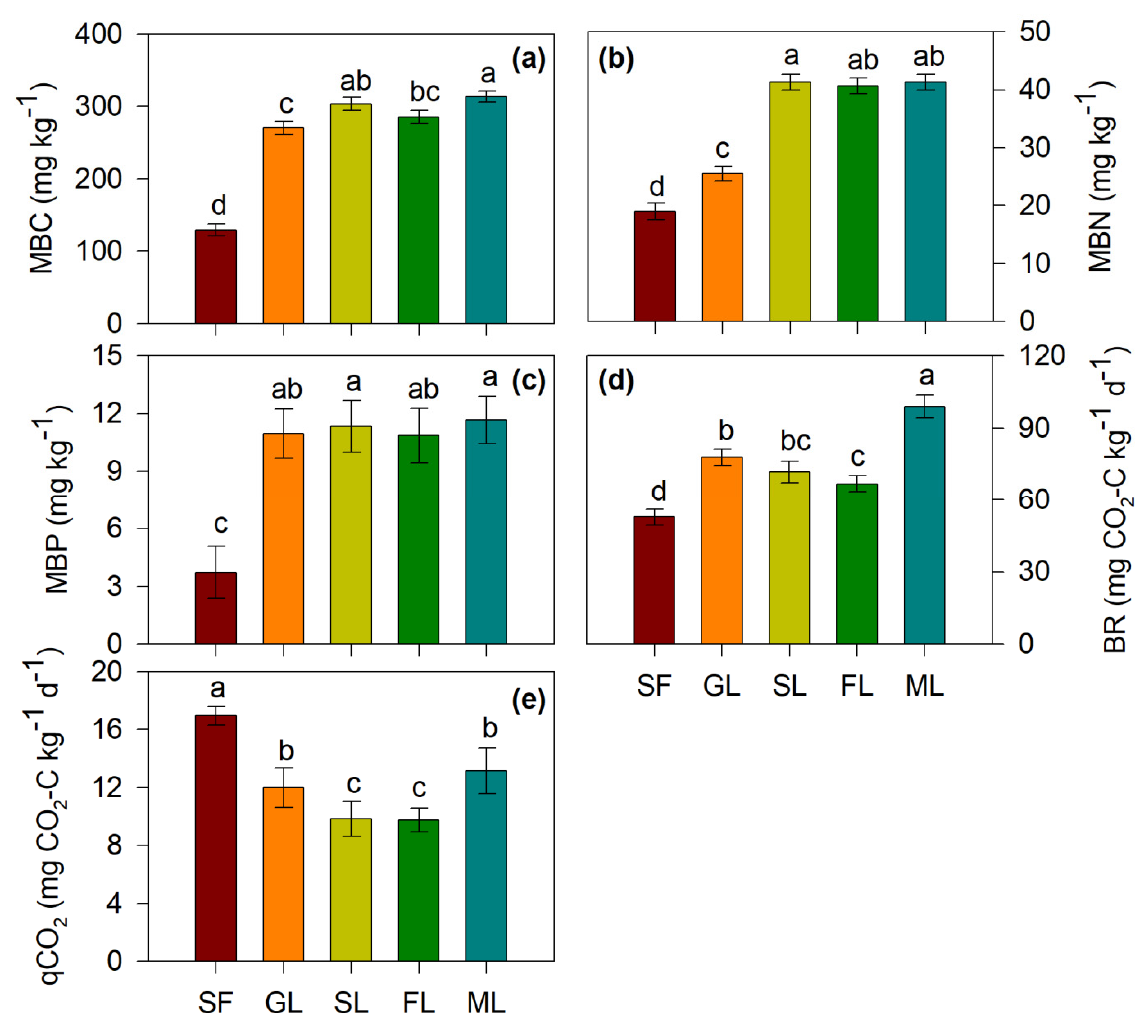
Figure 4. Microbial biomass C, N, P, respiration strength and qCO 2 values of soils in the seven land use types. MBC ( a ), Microbial biomass carbon; MBN ( b ), Microbial biomass nitrogen; MBP ( c ), Microbial biomass phosphorus; BR ( d ), Basal respiration; qCO 2 ( e ) , Microbial respiratory quotient. Note: SF, Sloping farmland; GL, Grassland; SL, shrubland of Caragana korshinskii ; FL, forestlands of Robinia pseudoacacia ; ML, mixed forests of Robinia pseudoacacia + Caragana korshinski . Different lower-case letters above the error bars indicate significant differences in different land use types at 0.05 level ( p < 0.05). Data are Means ± SE. n =